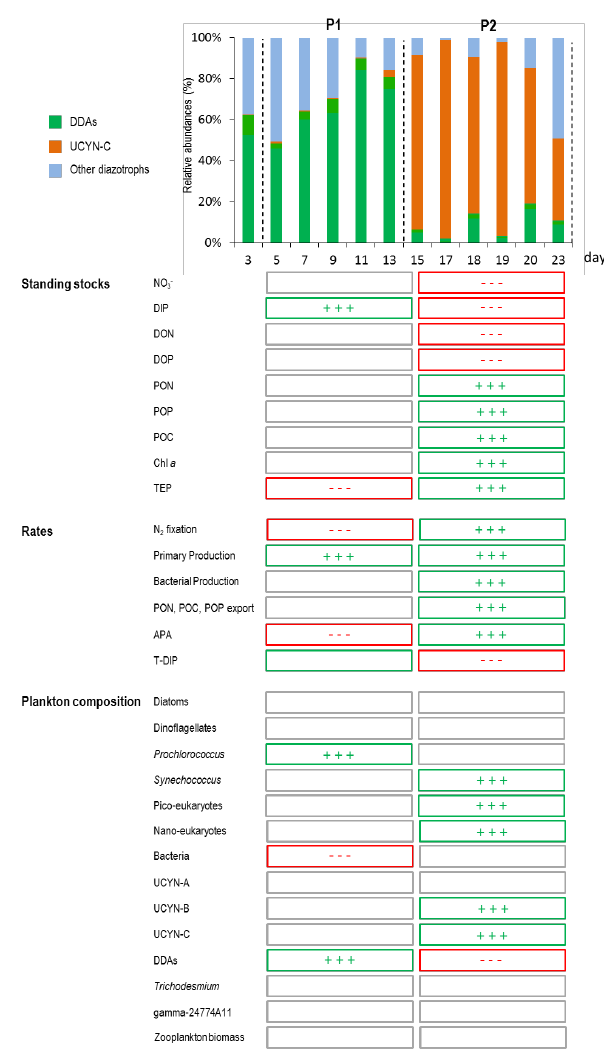
Figure 4. Upper panel: diazotroph community composition in the VAHINE mesocosm experiment during the experimental period. nifH -based abundances were summed for each sampling day to de- termine the percent contribution to the total diazotroph community from each major phylotype (data from Turk-Kubo et al., 2015). Bot- tom panel: simplified evolution of the major standing stocks, rates and plankton abundances measured during P1 (days 5 to 14) and P2 (days 15 to 23). Protocols for each parameter measurements are described in Berthelot et al. (2015b), Bonnet et al. (2016a, b), Van Wambeke et al. (2016), Berman-Frank et al. (2016), Leblanc et al. (2016), Turk-Kubo et al. (2015) and Hunt et al. (2016). Squares are represented in green when a significant ( p <0.05) increase was observed between each period (i.e. between P0 and P1 or between P1 and P2, Kruskall-Wallis test, α = 0.05), in red when a significant ( p <0.05) decrease was observed and in grey when no significant change was observed between the different